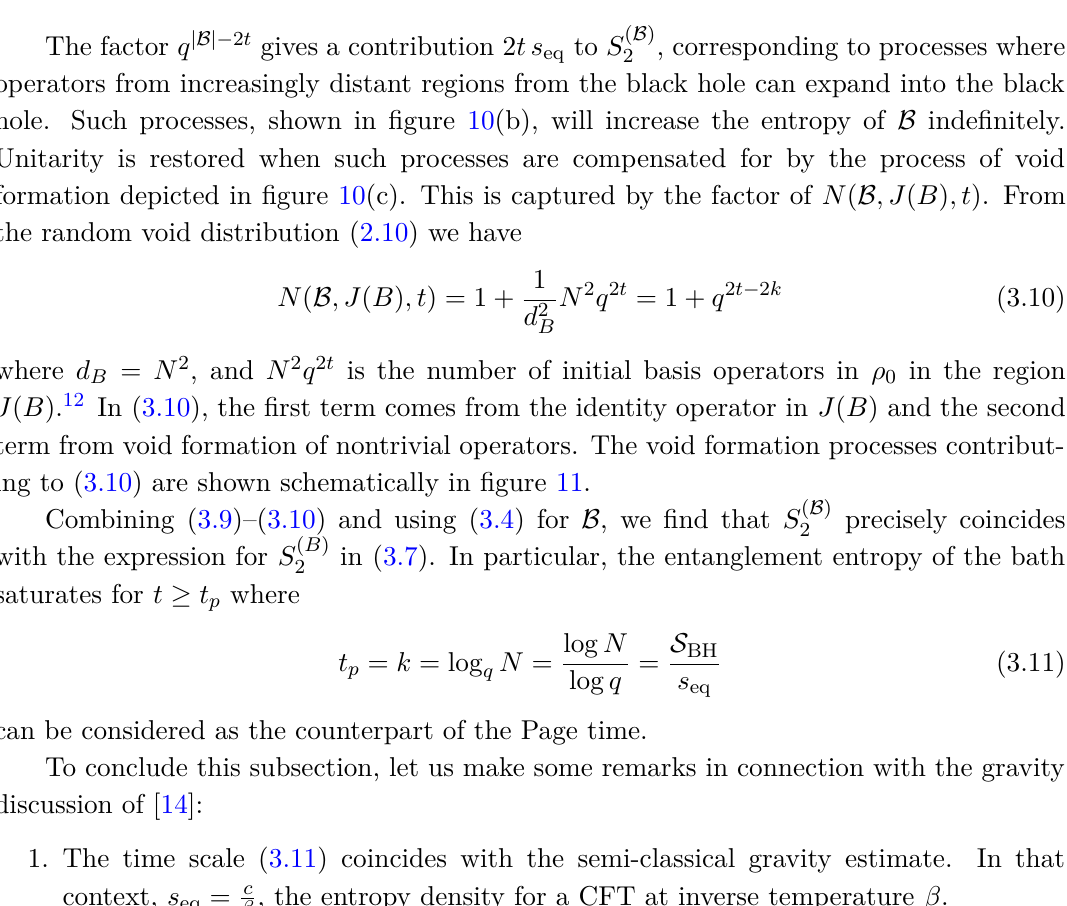
Figure 11 . Processes of forming a void in B , which result in final operators contained in B